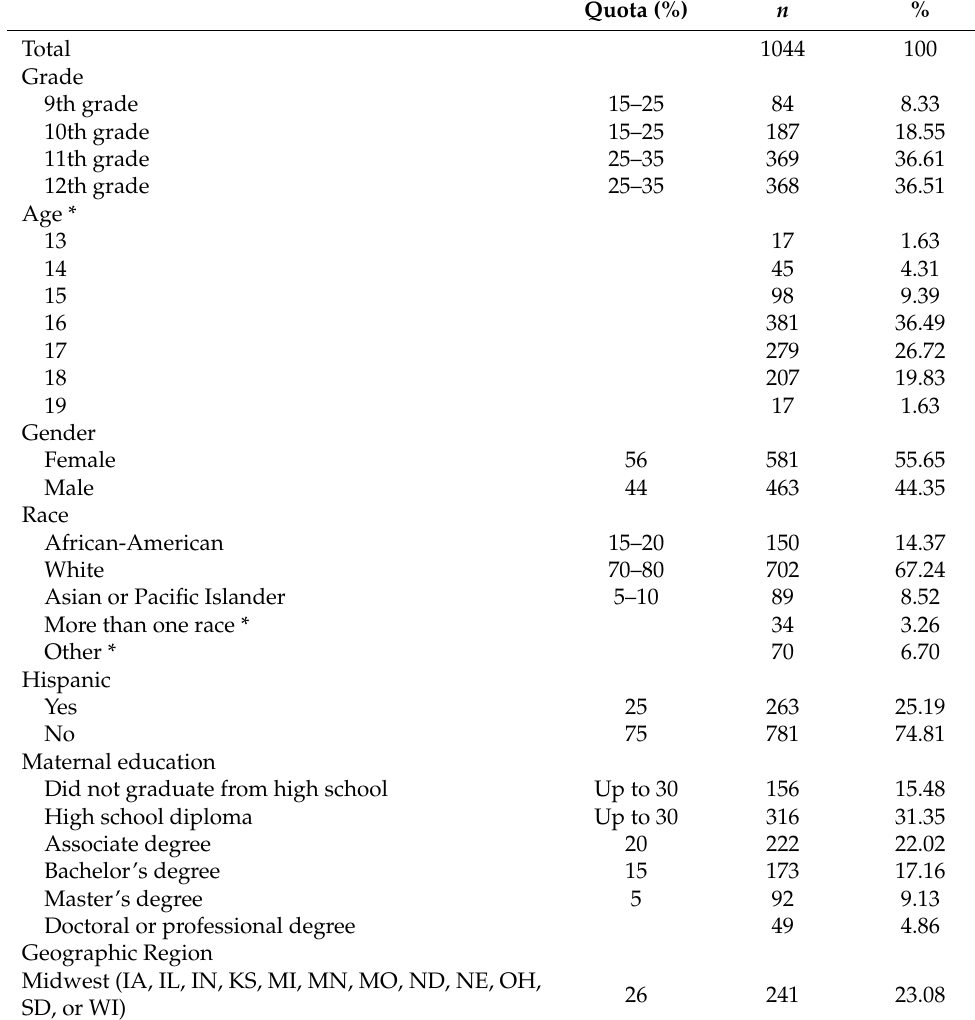
Table 1. Participants’ demographic